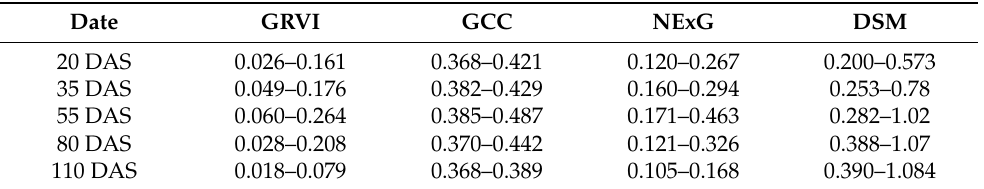
Table 3. The value ranges for all three (3) VIs and DSM values across the five (5) data collection dates at the resolution of the reference grid (10 × 10 m 2 ).